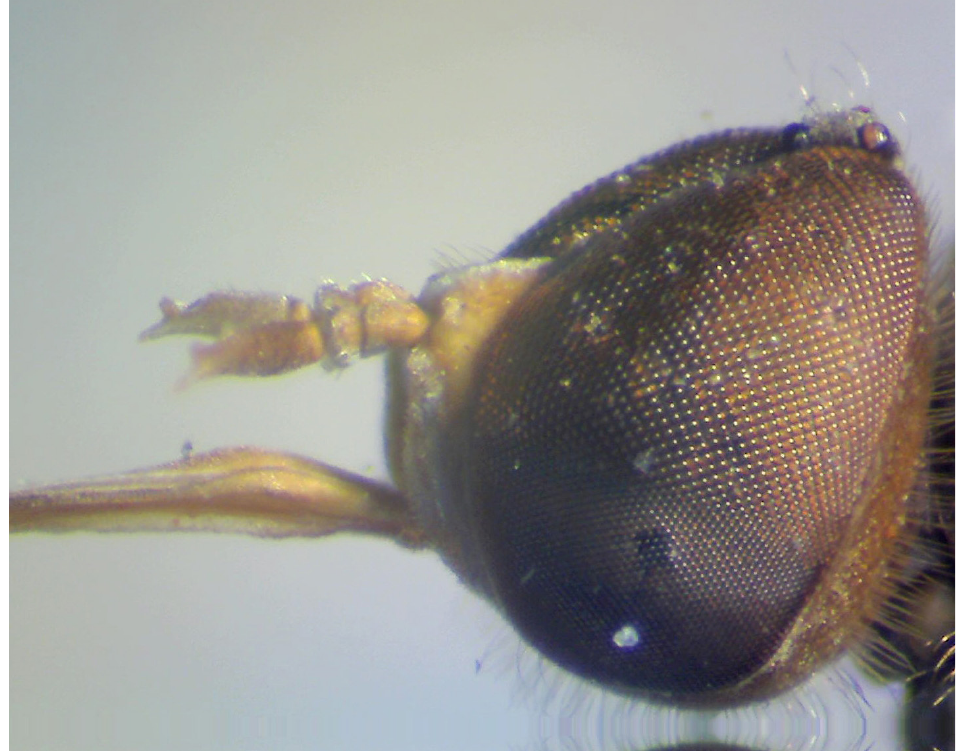
Fig. 4. Parageron longilingua sp. nov.,